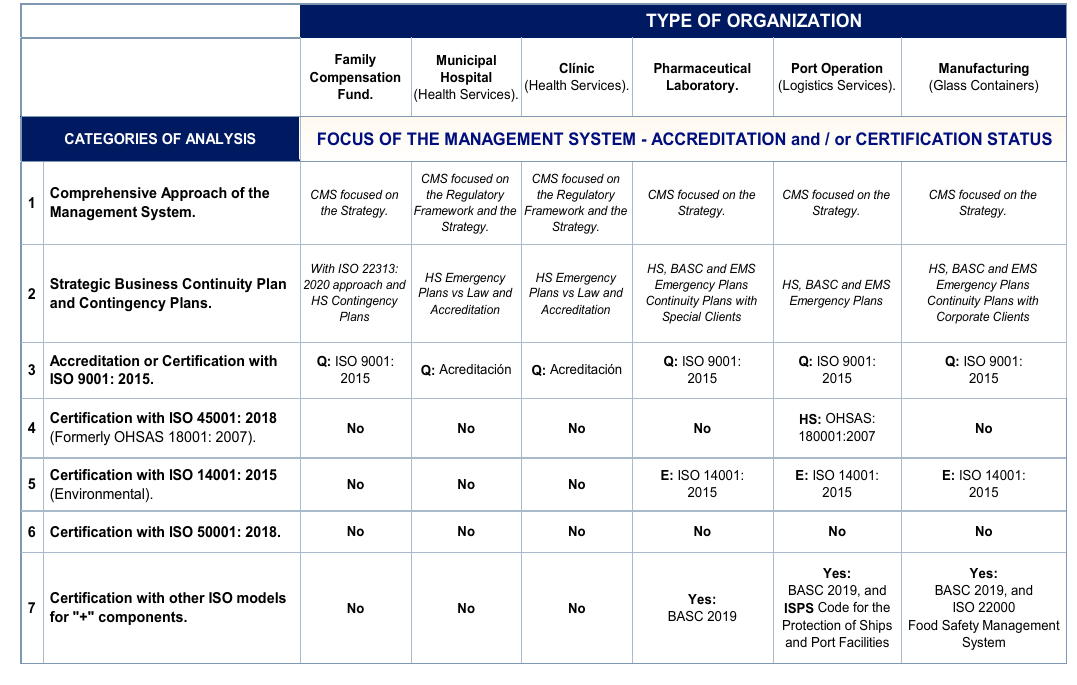
Figure 11. Characteristics of the companies in which the application of the comprehensive R/O management model was performed under CMS QHSE3+.